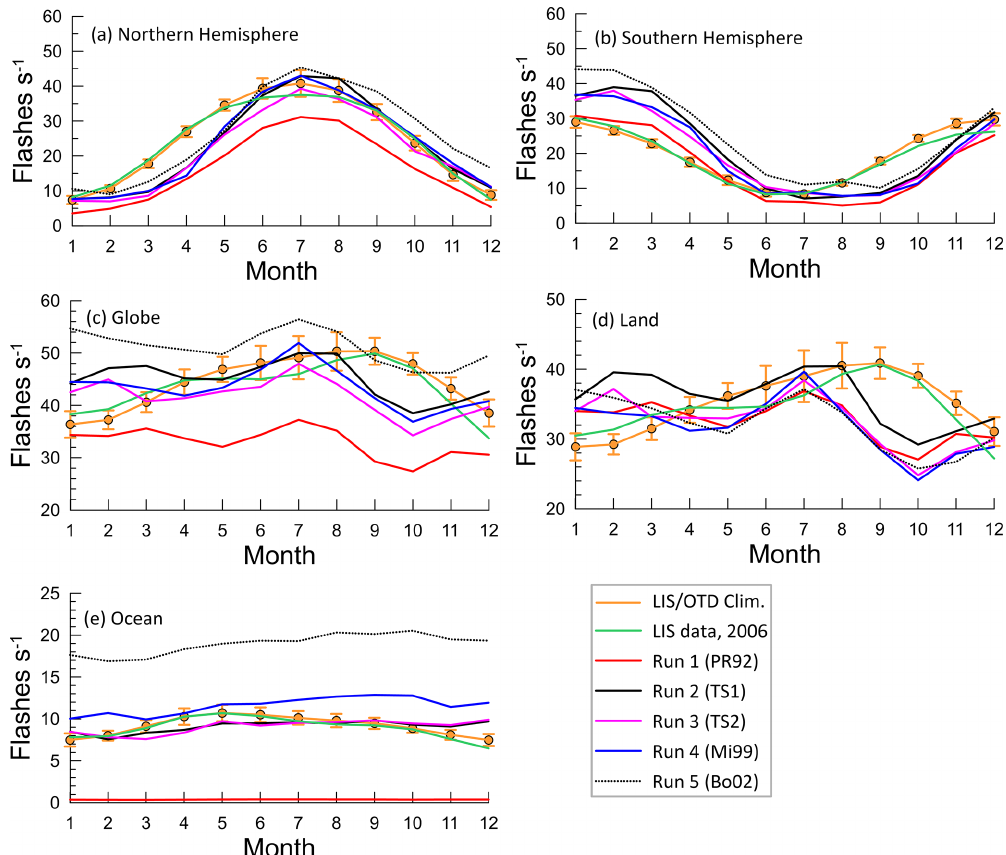
Figure 3. Monthly variation of the observed and modelled flash rates from the five model runs for the year 2006: (a) NH, (b) SH, (c) globe, (d) land, and (e) ocean. The observations are the LIS/OTD climatological data (with 1 standard deviation variability) and the LIS data for the year